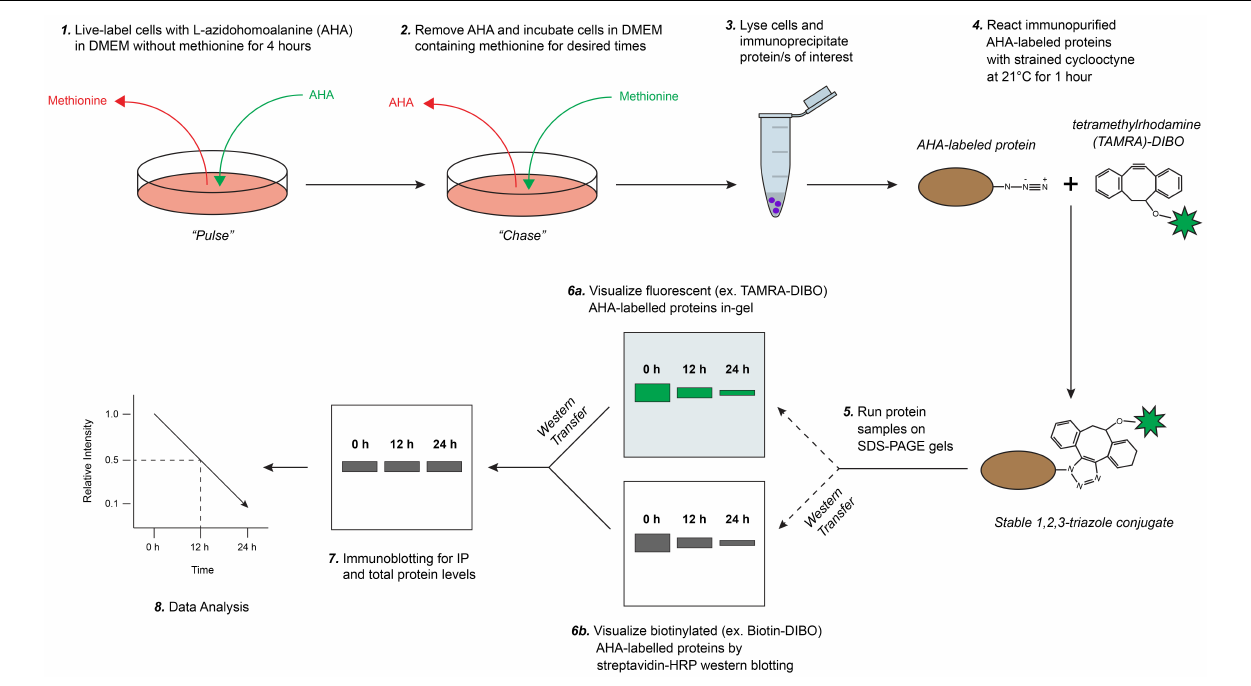
FIGURE 1 | Schematic overview of biorthogonal strain-promoted alkyne-azide cycloaddition (SPAAC) pulse-chase for fluorescent/chemiluminescent determination of protein half-life. (1) Briefly, cultured cells are live-labeled (pulsed) with L-azidohomoalanine (AHA), a bioorthogonal methionine analog that contains a reactive azide moiety, under methionine-free conditions. (2) AHA-containing media is removed and labeled cells are first washed then chased with media containing methionine for desired times (e.g., up to 24 h). (3) Cells are collected, lysed, and protein/s of interest are immunoprecipitated. (4) Immunopurified AHA-labeled proteins are reacted with a strained cyclooctyne (e.g., 4-dibenzocyclooctynol; DIBO) that is modified with either a fluorescent (e.g., tetramethylrhodamine; TAMRA) or biotin probe to form stable triazole conjugates. (5) AHA/cyclooctyne-labeled proteins are resolved on SDS-PAGE gels and either (6a) fluorescence is detected directly in-gel (e.g., labeled with TAMRA-DIBO) or, (6b) if labeled with a biotin-cyclooctyne probe, proteins are then transferred onto PVDF membranes and detected by chemiluminescence using a HRP-conjugated streptavidin. (7) Lastly, immunoblotting is completed to measure steady-state and immunoprecipitated protein levels from AHA/cyclooctyne-labeled protein samples, and (8) subsequently for downstream data analysis. Adapted with permission from Morey et al.